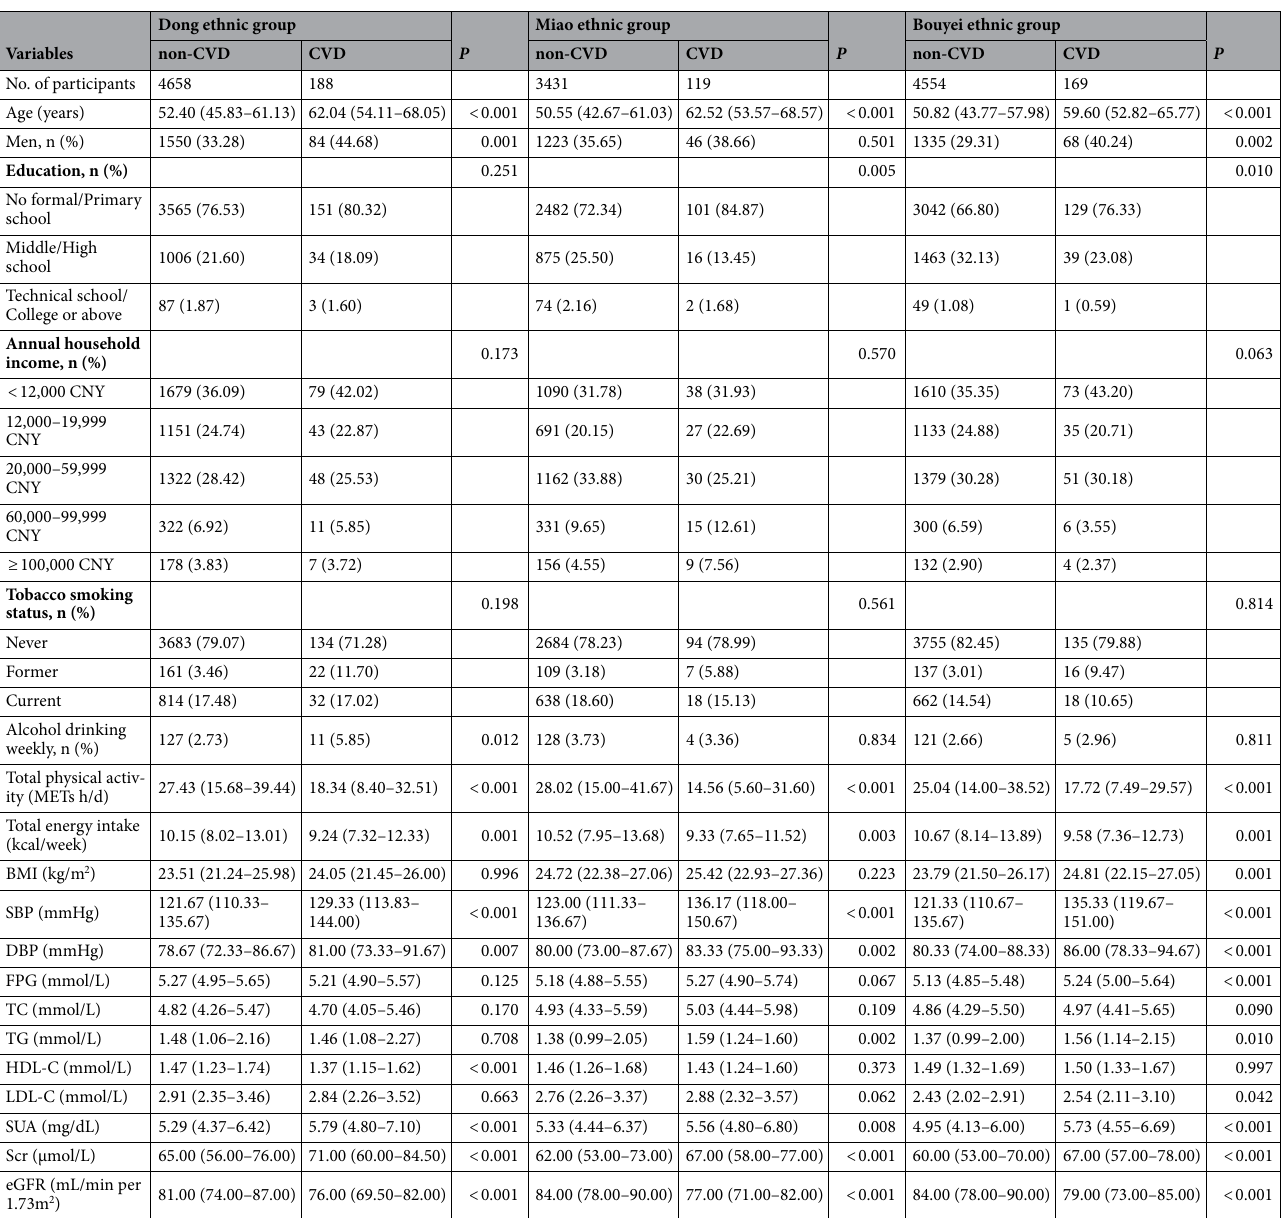
Table 1. Basic characteristics of the Dong, Miao, and Bouyei ethnic groups by cardiovascular disease status in rural areas. BMI body mass index; CNY Chinese Yuan; CVD cardiovascular disease; DBP diastolic blood pressure; eGFR estimated glomerular filtration rate; FPG fasting plasma glucose; HDL-C high-density lipoprotein-cholesterol; LDL-C low-density lipoprotein-cholesterol; METs h/d metabolic equivalent tasks hours/day; SBP systolic blood pressure; Scr Serum creatinine; SUA serum uric acid; TC total cholesterol; TG triglycerides. Data are presented as number (percentage) for categorical variables and median (interquartile range) for continuous variables. P comparing non-CVD and